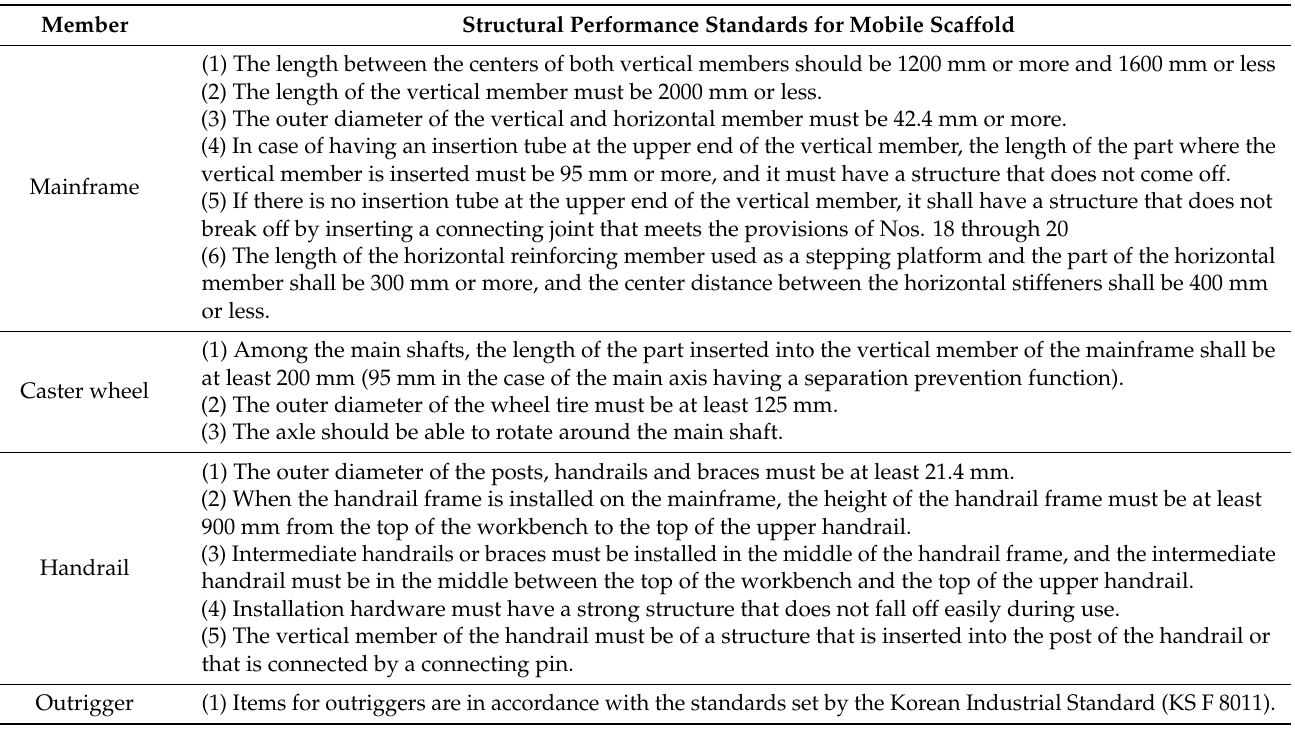
Table 6. Structural performance standards for mobile scaffold.